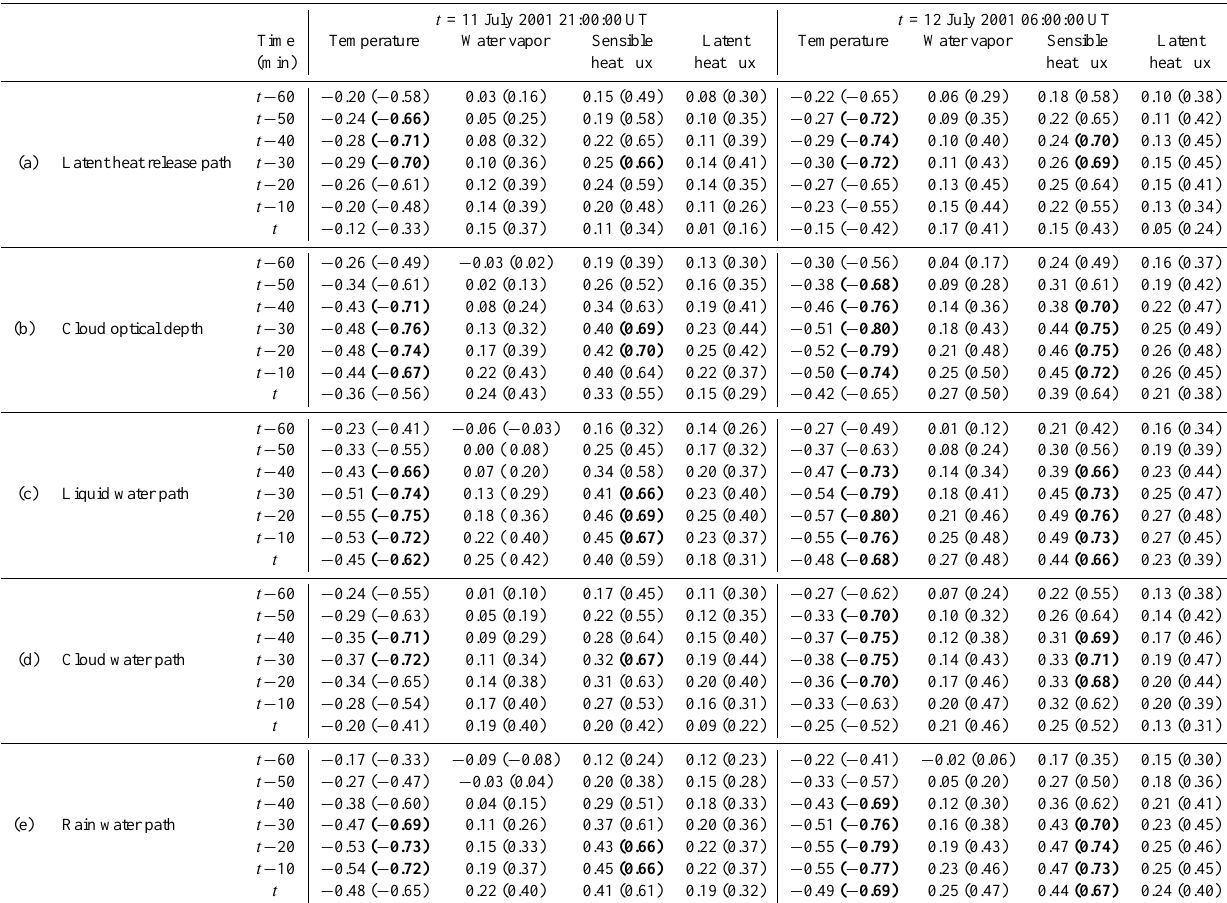
Table 3. Lagged spatial correlation coefficients of surface quantities and vertically integrated cloud properties in simulation S ◦ . Correlation coefficients with an absolute value ≥ 0 . 66 are highlighted in bold. Correlation coefficients in parentheses were calculated from data after filtering with a circular low-pass filter with a diameter of